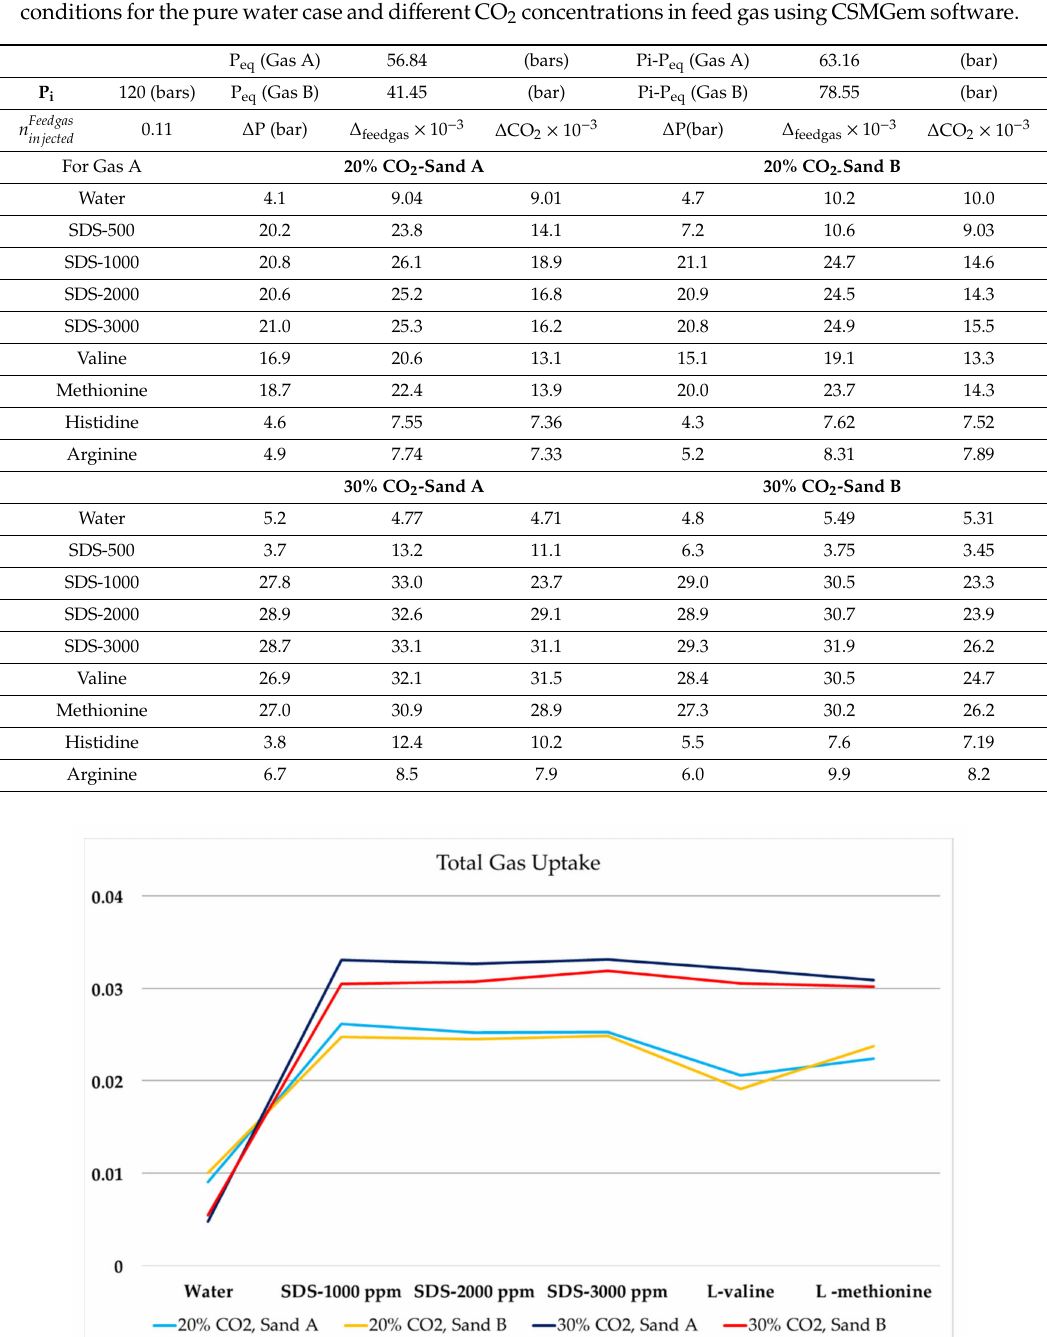
Figure 10. Total gas uptake due to changes in the sand (Sand A and Sand B) for di ff erent CO 2 concentrations of feed gas (Gas A and Gas B) in the presence of di ff erent chemicals from Table